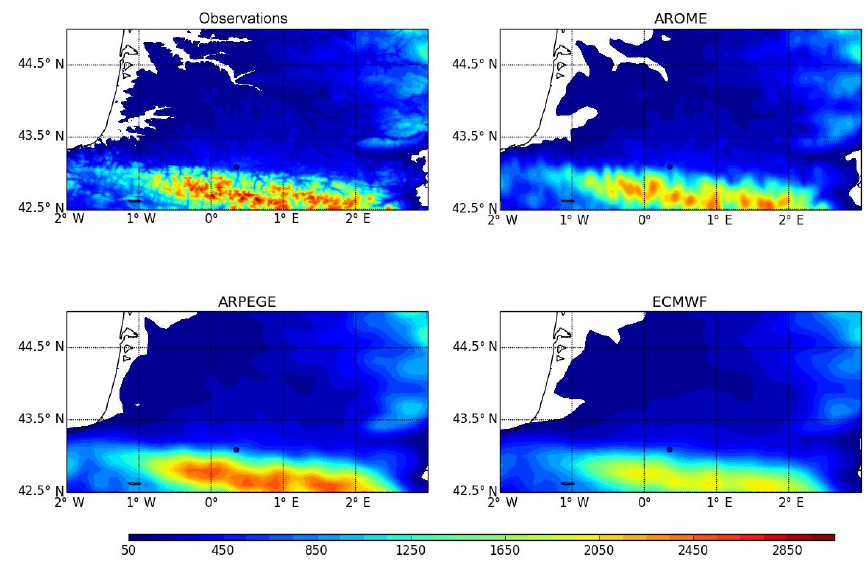
Figure 2. Orography as (upper left) observed (ETOP01 dataset) or modelled in AROME (upper right), ARPEGE (lower left) and ECMWF (lower right); isocontours every 100m are